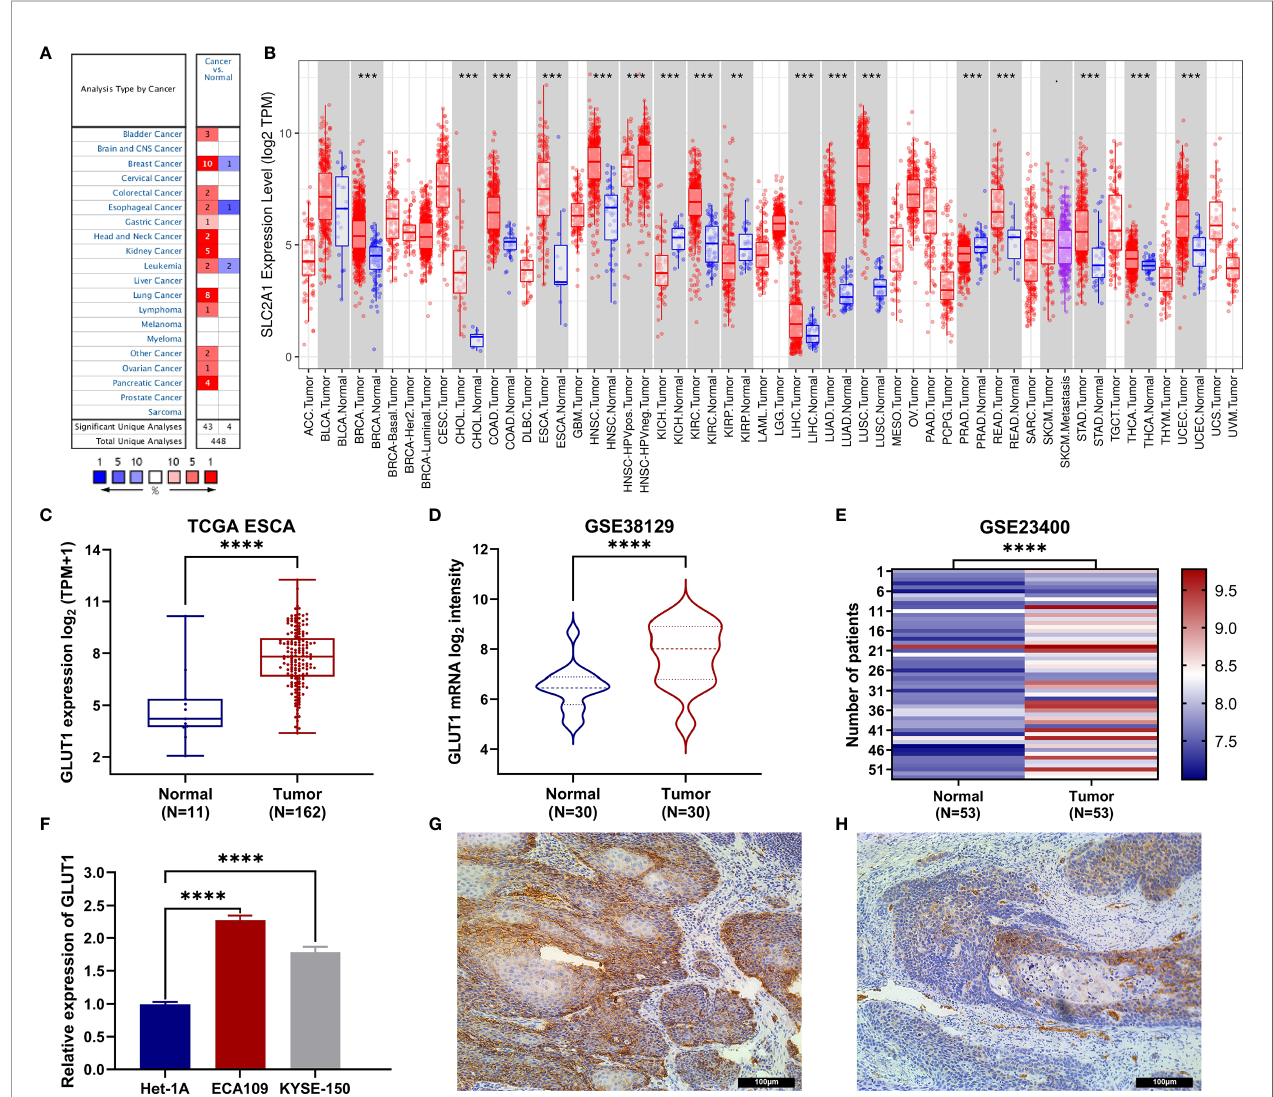
FIGURE 1 | The expression of GLUT1 in esophageal carcinoma (ESCA) and pan-carcinoma. (A) The Oncomine database shows that GLUT1 is up-regulated in multiple tumor types. (B) GLUT1 expression levels in different tumor types were measured using TIMER. (C) TCGA cohort analysis of the expression level of GLUT1 between ESCA and normal tissues. (D) The GSE38129 data set was used to analyze the expression level of GLUT1 between ESCA and normal tissues. (E) The GSE23400 data set was used to analyze the expression level of GLUT1 between ESCA and paired normal adjacent tissues. (F) The expression of GLUT1 in human esophageal carcinoma ECA109 cell line, KYSE-150 cell line and human normal esophageal epithelial cells Het-1A. Immunohistochemistry assay was used to analyze the expression of GLUT1 in ESCA tissues (G) , in paracarcinoma tissues (H) . * p < 0.05; ** p < 0.01; *** p < 0.001; **** p <